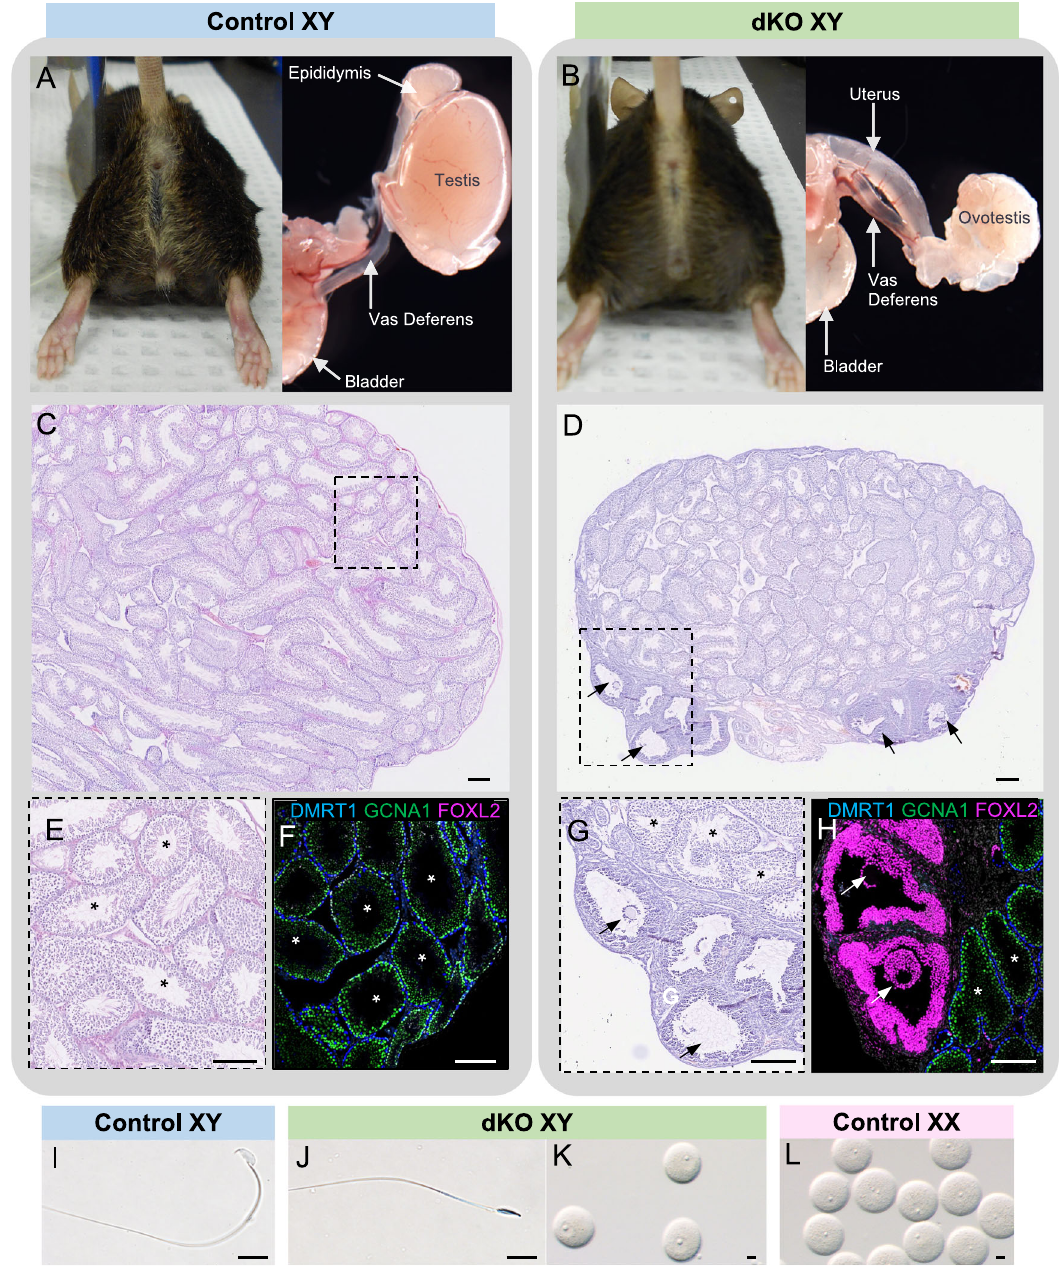
Fig. 1 Loss of Amh/Inhbb in the XY mice leads to intersex phenotypes with ovotestis that produce oocytes and sperm in adulthood. A , B The external and internal genitalia of the fi ve months old control and dKO XY mice. C , D Hematoxylin & Eosin staining of a section of control and dKO XY gonads at fi ve months of age. Scale bar = 200 µ m. E , G Higher magni fi cation of the dotted lined area in C , D . F , H Immuno fl uorescence for DMRT1 (Sertoli cells, blue), GCNA1 (germ cells, green), and FOXL2 (granulosa cells, pink) in control and dKO XY gonads. Stars and arrows mark seminiferous tubules and follicles, respectively. Scale bar = 200 µ m. I – L Sperm and oocytes were recovered from the control XY (sperm only, n = 2/2), control XX (oocytes only, n = 4/4) and dKO XY mice (both sperm and oocyte, n = 2/4) 46 h after PMSG stimulation. Scale bar = 25 µ